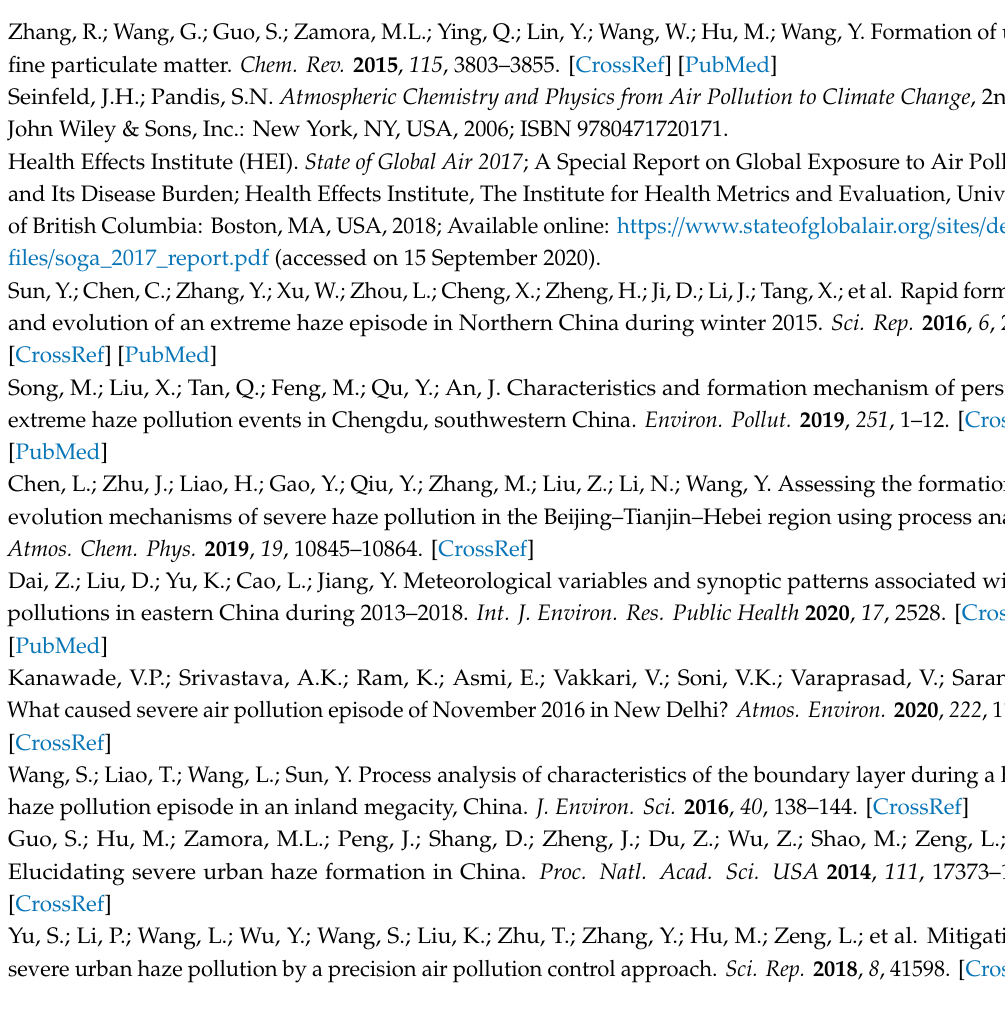
Table S1. Selected air pollution studies in Greater Bangkok. Figure S1. Daily PM 2.5 variation at the three air quality stations by year: (a) 2015; (b) 2016; (c) 2017. Figure S2. Example surface charts in EP1 corresponding to the four synoptic patterns classified: (a) Pattern 0; (b) Pattern 1; (c) Pattern 2; (d) Pattern 3. Figure S3. Example surface charts in EP2 corresponding to the four synoptic patterns classified: (a) Pattern 0; (b) Pattern 1; (c) Pattern 2; (d) Pattern 3. Figure S4. Diurnal variation of PM 2.5 and Obukhov length ( L ) during: (a) EP1 in 2015; (b) EP2 in 2017. Figure S5. Vertical migration of each individual daily 48-h back-trajectory: (a) EP1 in 2015; (b) EP2 in 2017. Figure S6. Average daily active fire hotspots per pixel (0.5 ◦ by 0.5 ◦ ): (a) EP1 in 2015; (b) EP2 in